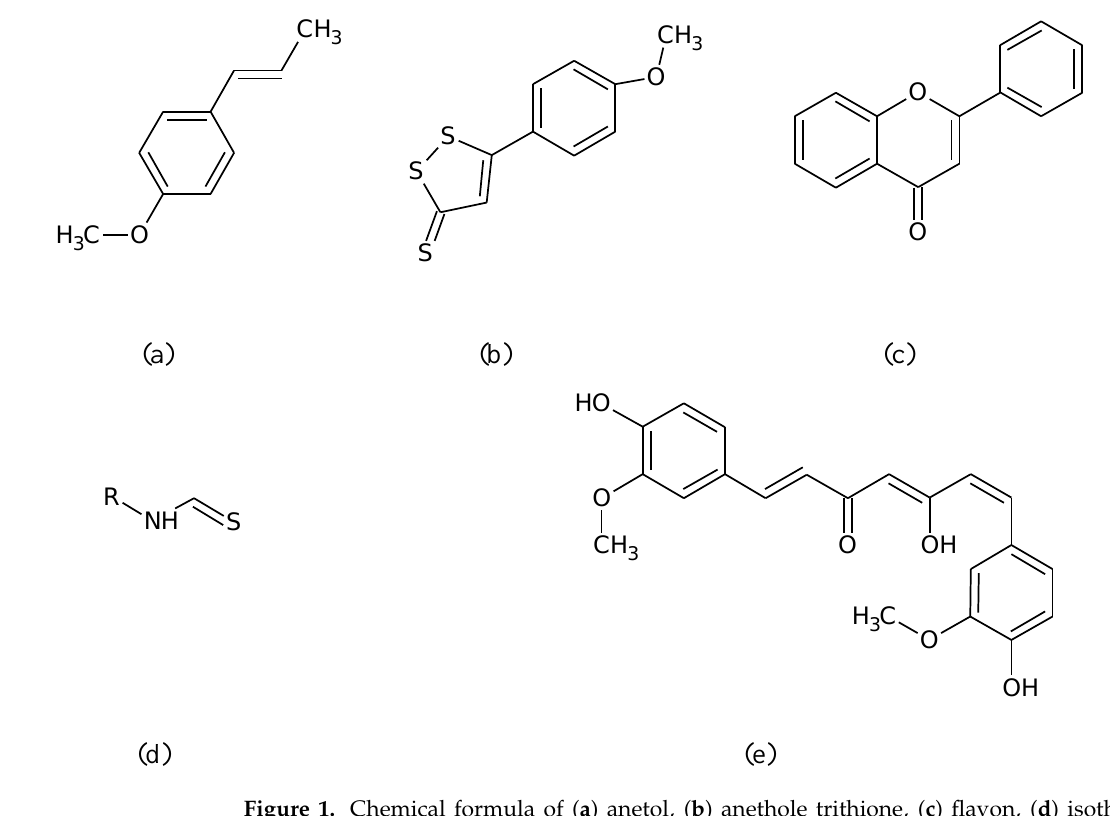
Figure 1. Chemical formula of ( a ) anetol, ( b ) anethole trithione, ( c ) flavon, ( d ) isothiocyanates, ( e ) curcumin.